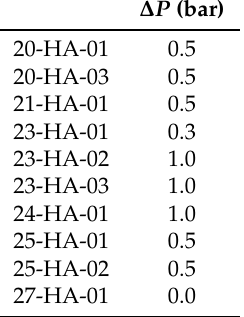
Table 3. Applied modeling details for unit operations. For 20-HA-02 the duty is assumed to be zero i.e., no inter-stage heating applied between first and second separation stage. A fixed temperature is applied for the discharge of the dehydration inlet cooler, 24-HA-01, of 30 ◦